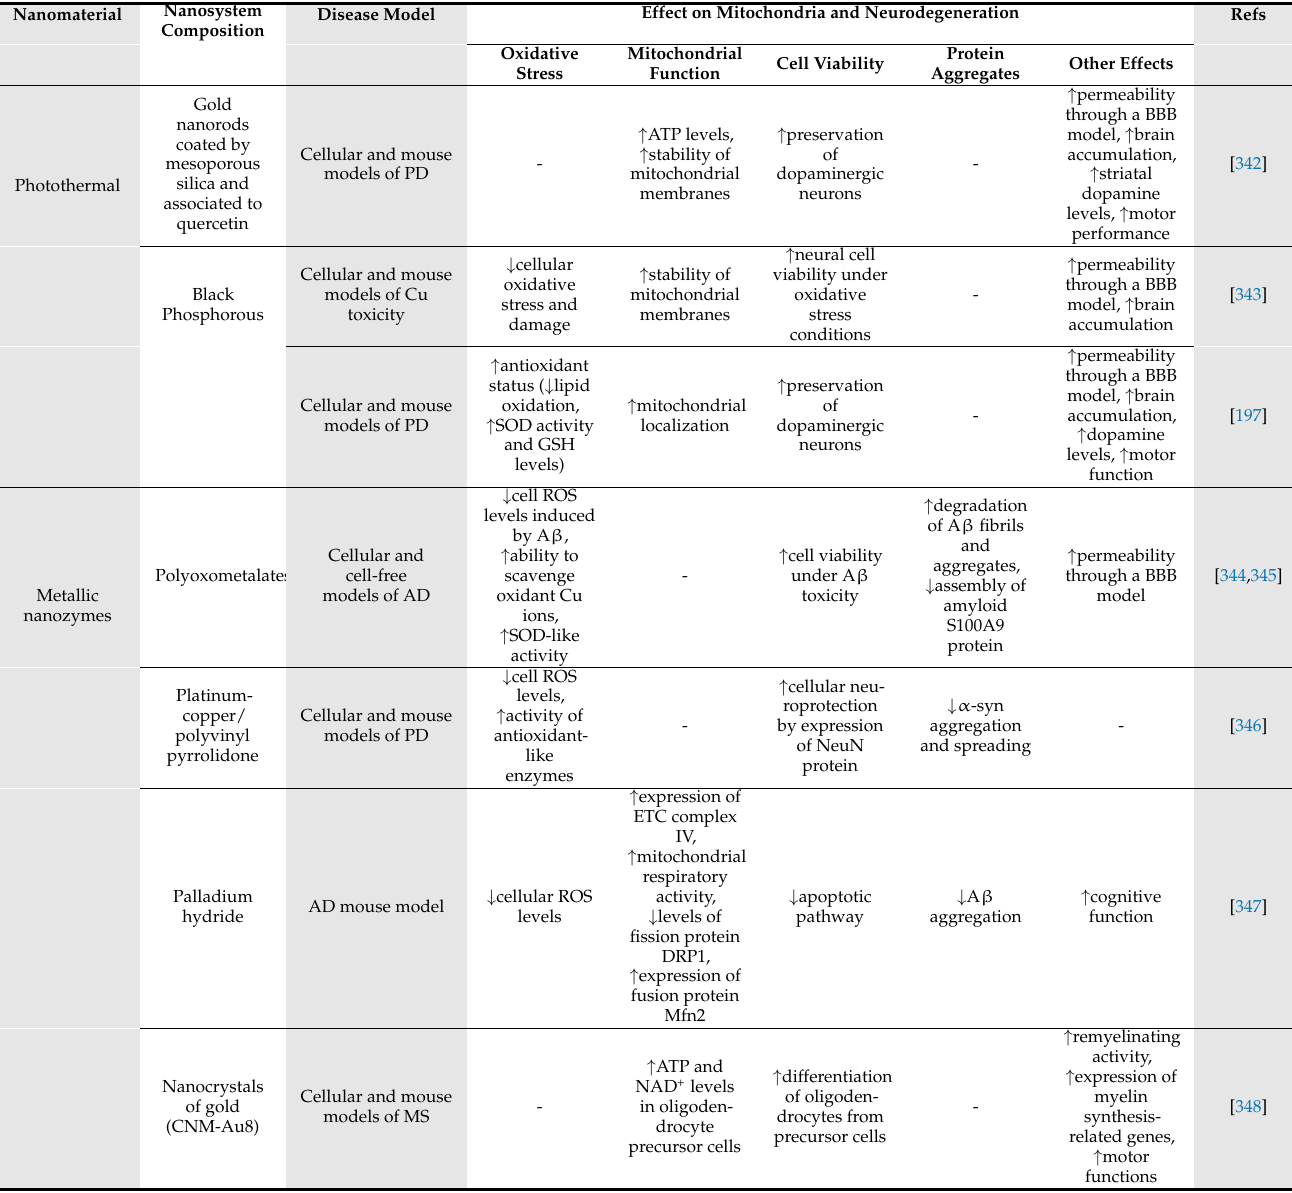
Table 6. Therapeutic nanomaterials for mitochondrial dysfunction in models of neurodegenerative